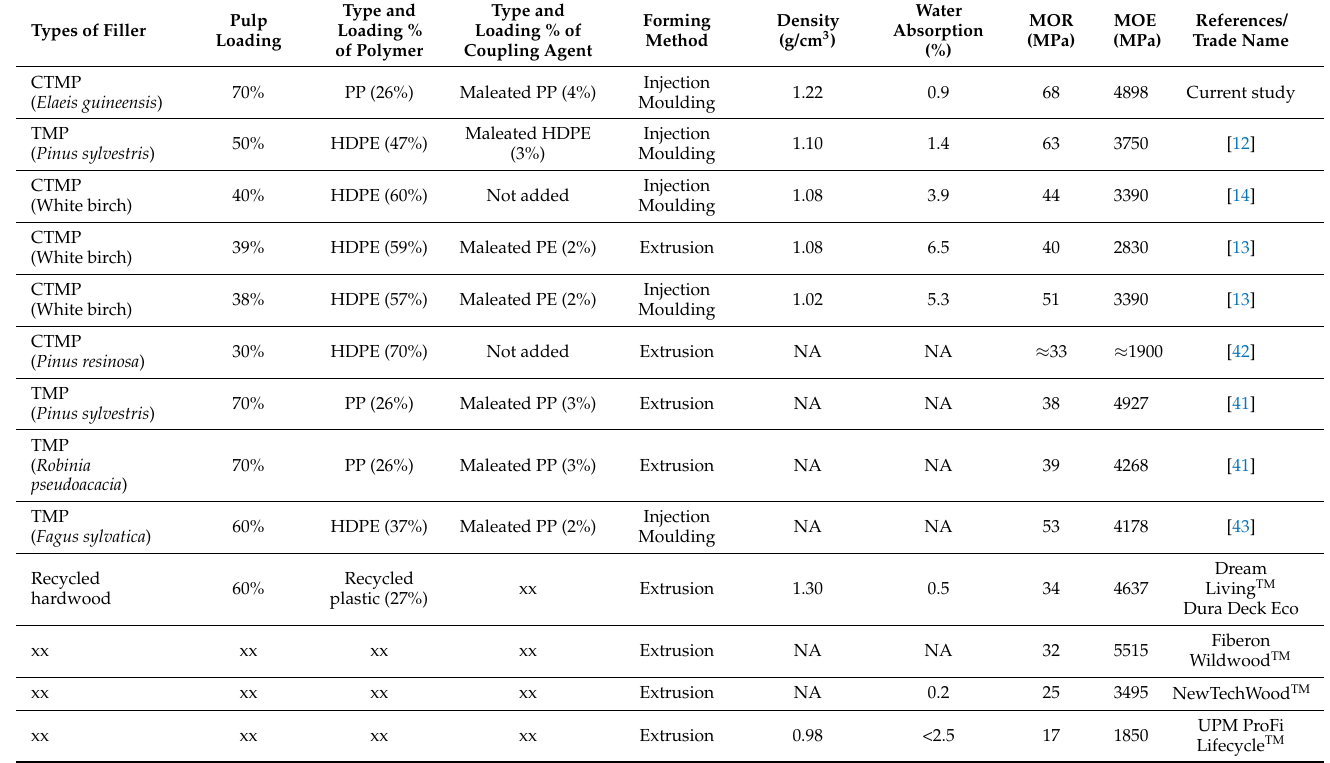
Table 11. Comparison of the current study and other published studies based on the properties of WPCs reinforced with